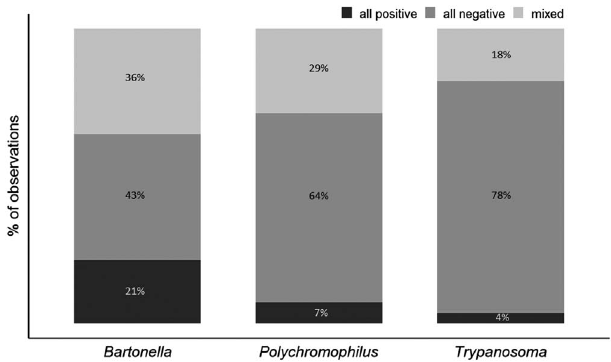
Figure 2. Prevalence of Bartonella spp., Polychromophilus spp., and Trypanosoma spp. infection in nycteribiid fl ies collected from 28 bats, which carried between 2 and 7 fl ies. Black: all fl ies are infected, dark grey: all fl ies are non-infected, light grey: both infected and non-infected fl ies occurred on the same